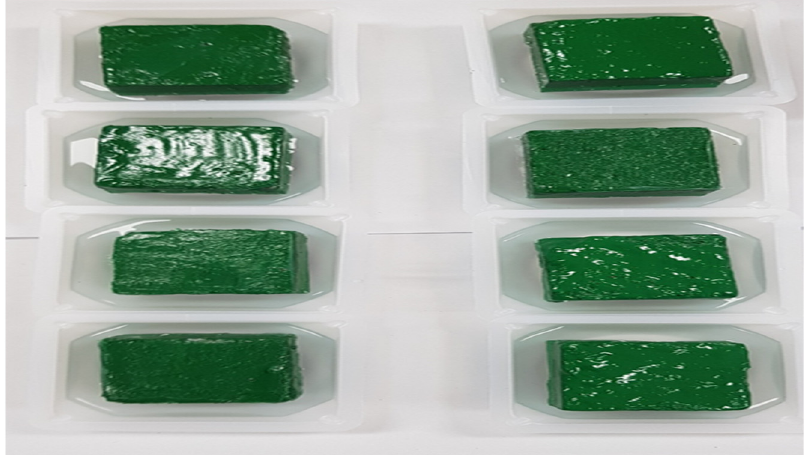
Figure 11. Results of the NT Build 492 test (91 d).